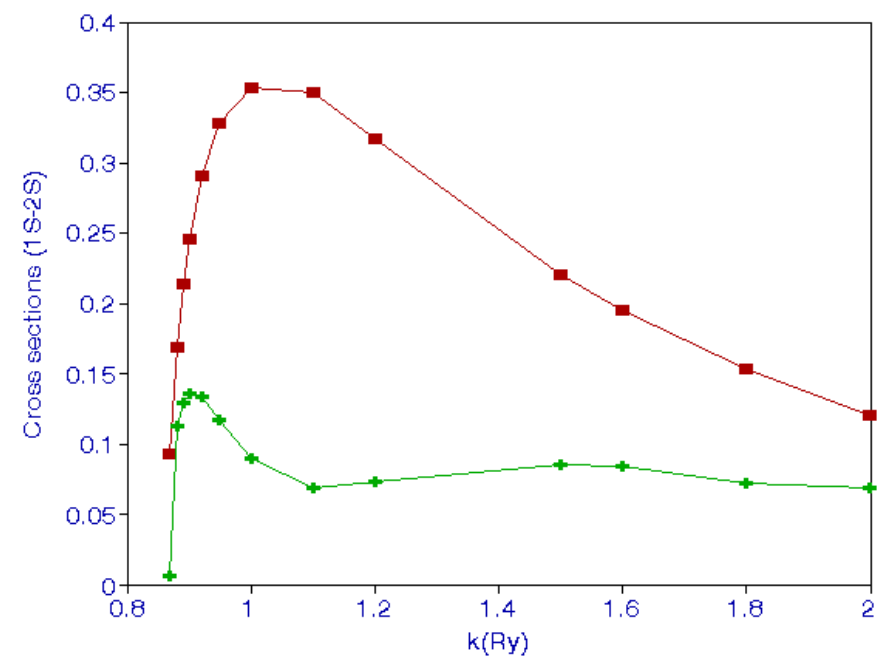
Figure 3. (Color online) Comparison of the 2 S excitation cross sections as a function of the incident k of positron (upper curve) and electron impacts (lower curve).